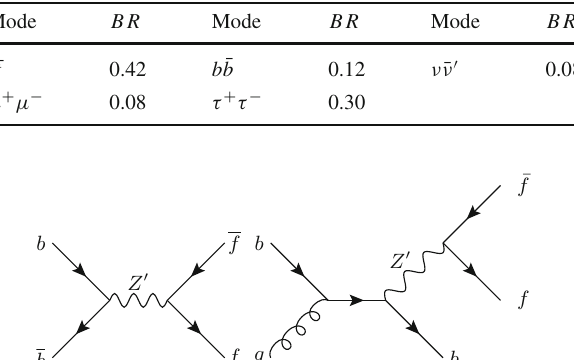
Table 2 Branching ratios of various Z (cid:2) decays predicted by the TFHM in the M Z (cid:2) (cid:8) 2 m t limit, from Ref. [1]